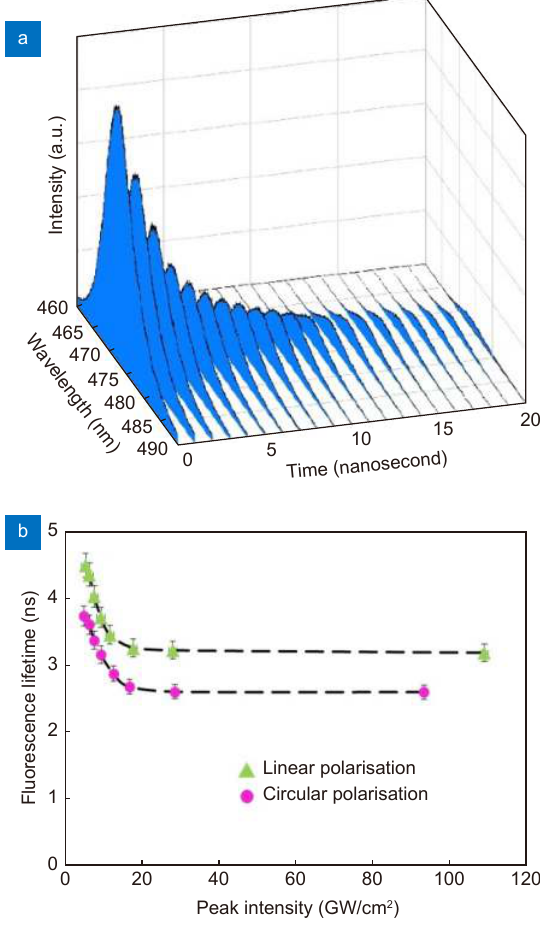
Fig. 12 | ( a ) Fluorescence decay curve against time. ( b ) polarisation effect on fluorescence lifetime ( λ = 775 nm, τ = 200 fs). Linear polar- isation results in longer upper state lifetimes while due to stronger coupling (third order susceptibility higher with linear